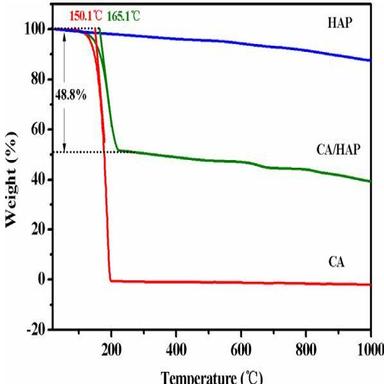
TGA curves of CA, HAP and CA/HAP composite.